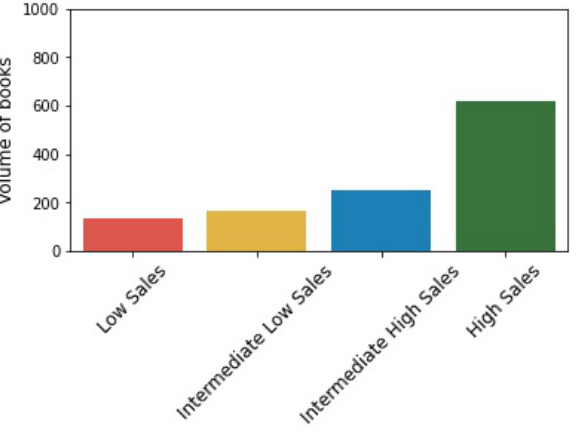
Figure 4. Distribution of the volume of books for each of the segmentations by quartiles. The results show a significant data imbalance between the different